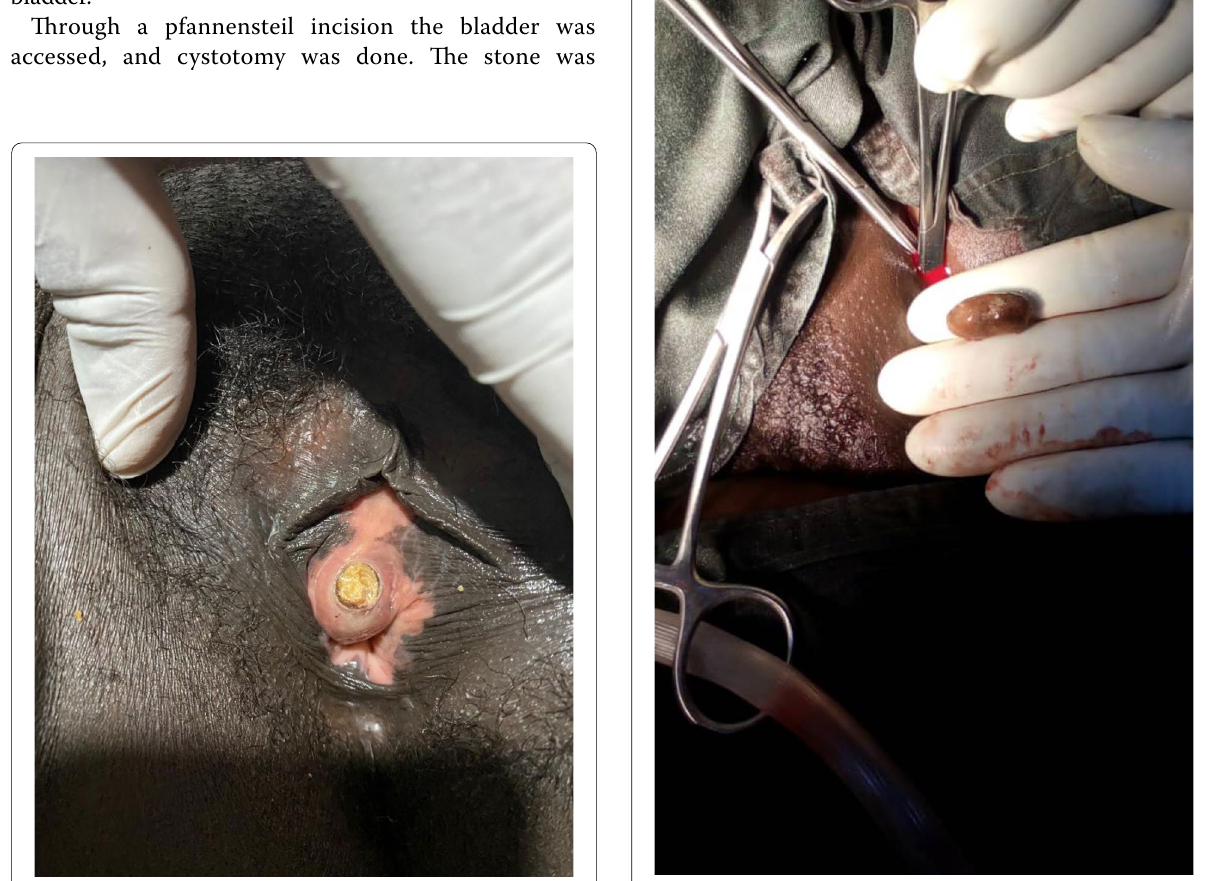
Fig. 1 Stone image at vaginal examination Fig. 2 Stone image during